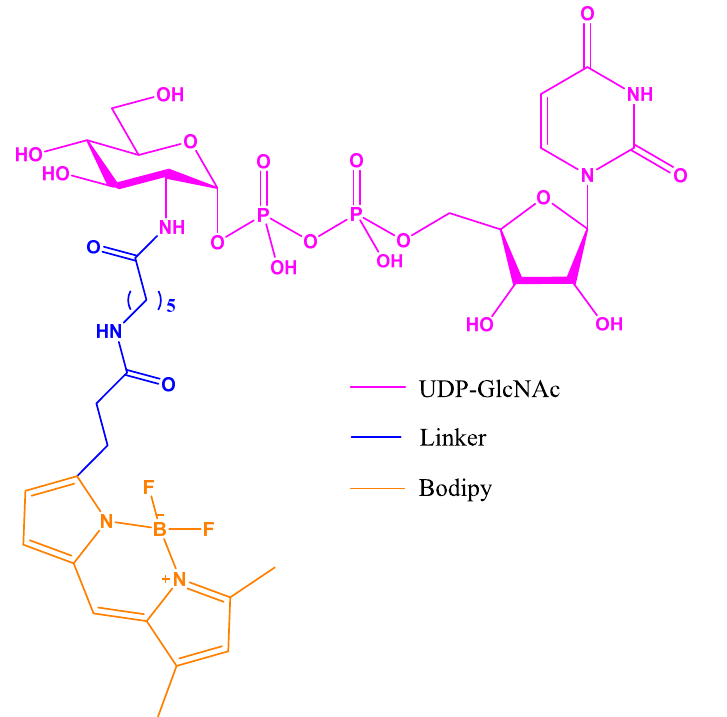
Figure 11. UDP-GlcNAc with Bodipy fluorescent probe attached via a modified acetyl group at